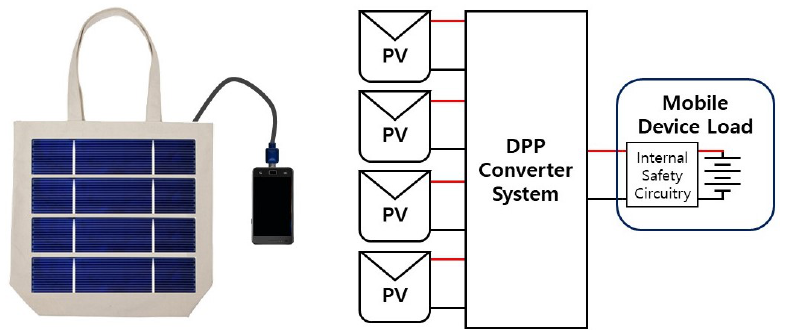
Figure 2. PV-powered device: charging bag concept.